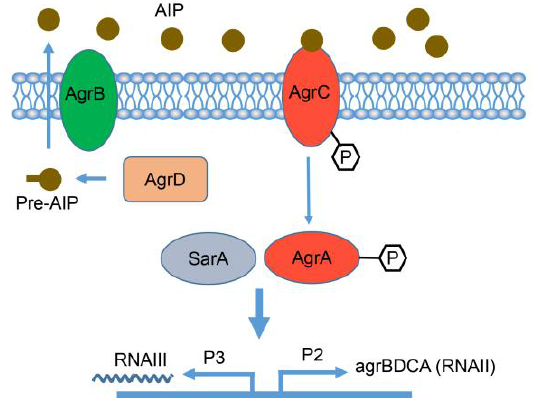
Figure 6. QS system pathways based on multi-omics analysis of heat-resistance in RS047-wl. The agr locus is composed of two divergent transcripts referred to as RNAII (agrBDCA) and RNAIII, which are under the control of the P2 and P3 promoters, respectively. AgrD is the peptide precursor of the auto-induced peptide (AIP), which is processed and exported through AgrB. At the threshold concentration, the AIP binds to the AgrC receptor, resulting in phosphorylation of the AgrA response regulator. This leads to activation of the P2 and P3 promoters. The green oval represents significantly down-regulated genes in RS047-wl compared to WT RS047; the red oval represents significantly up-regulated genes in RS047-wl compared to WT RS047.